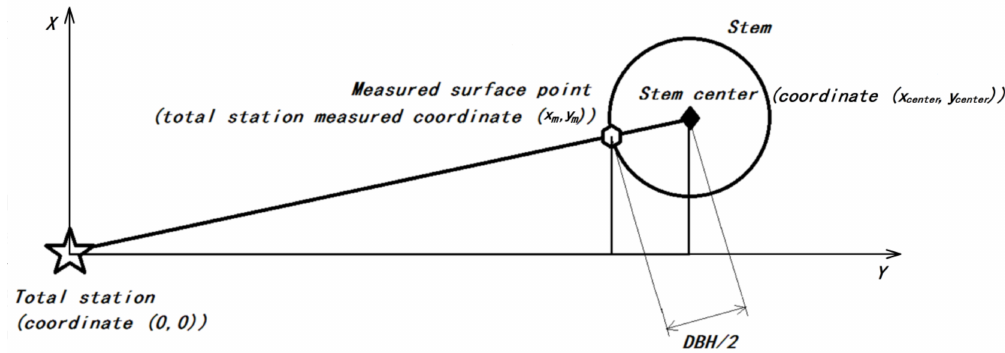
Figure 2. Positional relationship among total station, the measured surface point, and the stem